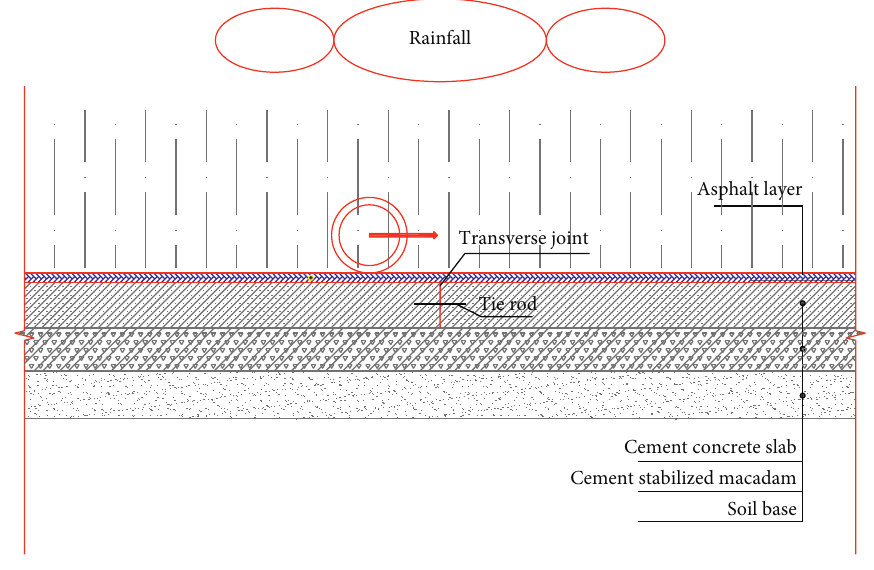
Figure 1: Schematic diagram of a complete pavement structure.